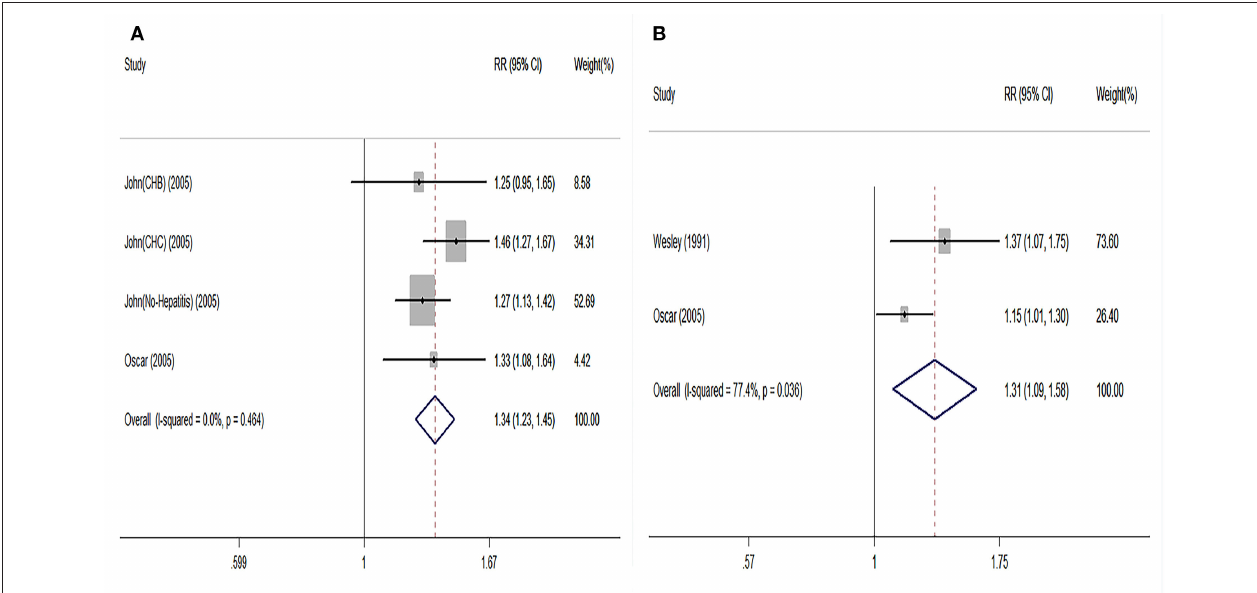
FIGURE 3 | Pooled results on comparison in LT cases categorized by grafts from adults and adolescents. (A) Pooled RR on graft failure between adult and adolescent groups. (B) Pooled RR on patient death between adult and adolescent groups. Adults were defined as the donors aged elder than 18 years; adolescents were defined as the donors aged younger than 18 years. RR, relative risk; LT, liver